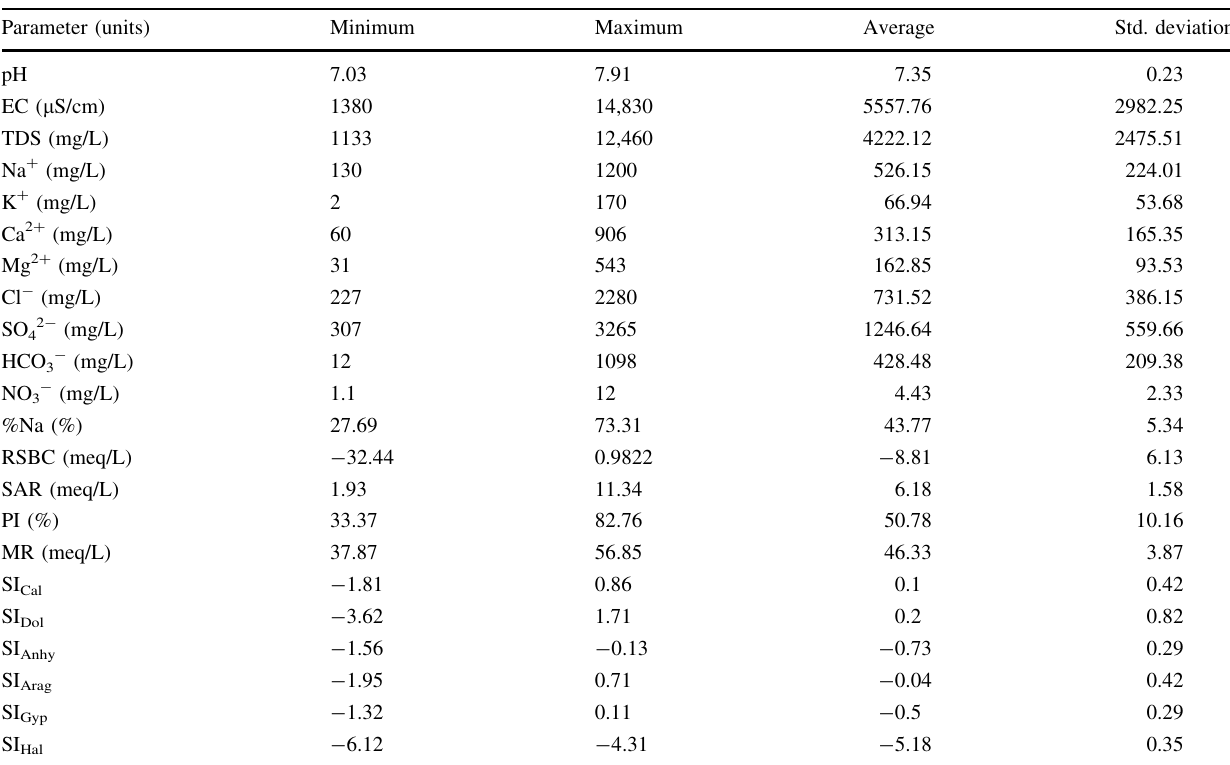
Table 2 Summary statistics for physico-chemical and irrigation quality parameters of groundwater with saturation indices (SI) of selected minerals in the study area Parameter